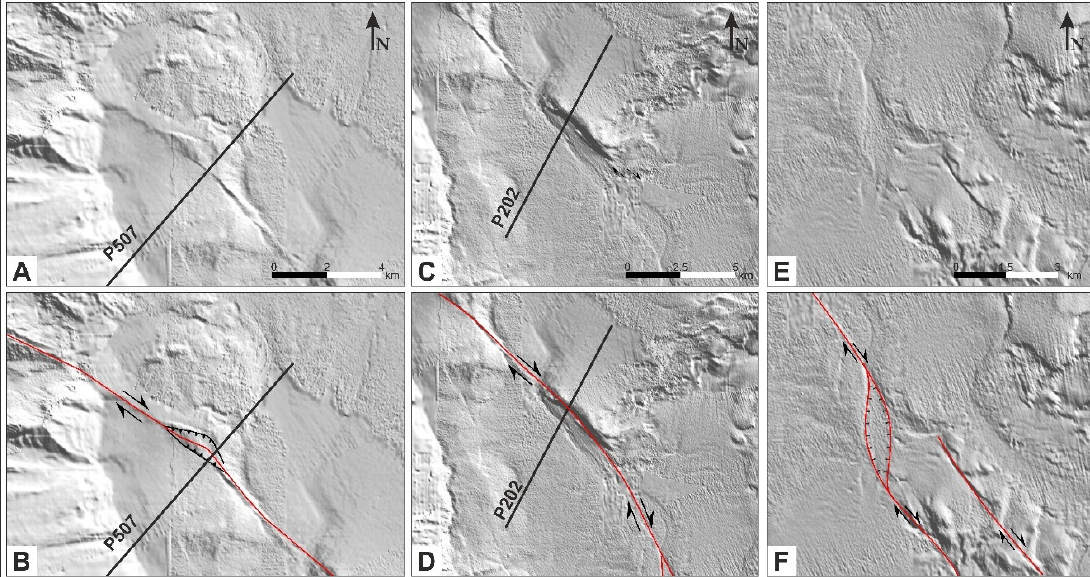
Figure 9. Morphostructural features along the North Alfeo Fault: restraining bend ( A , B ), diapir- related ( C , D ) and releasing bend ( E , F ) geometries (see location in Figure 5).